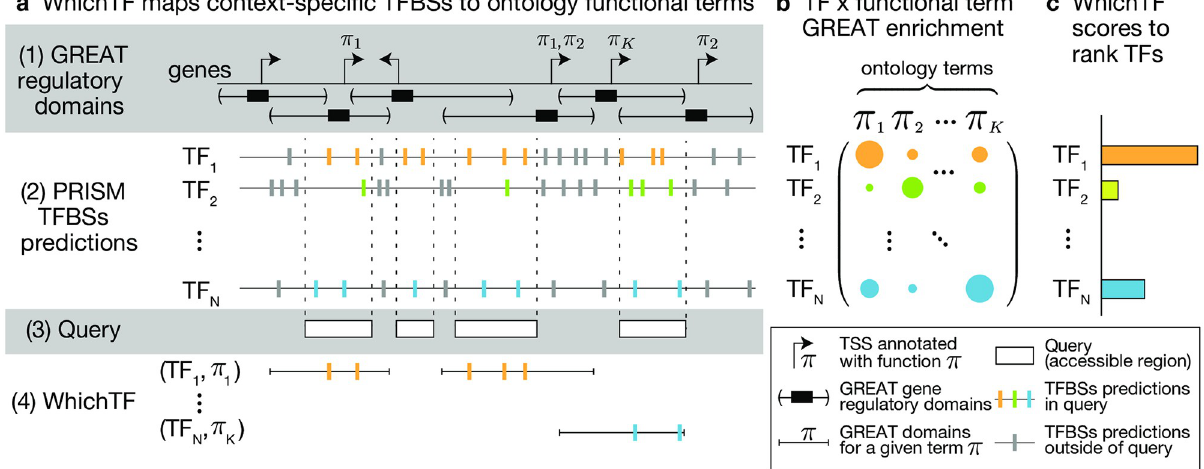
Fig 1. The WhichTF computational model. (a) WhichTF uses gene regulatory domain models and functional information in ontologies from the genomic region enrichment analysis tool (GREAT) (step 1) and conservation-based PRISM predictions of transcription factor binding sites (TFBS) (step 2). Given a user-defined set of putative gene regulatory genomic regions (step 3), WhichTF considers the top- K GREAT functional terms ( π 1 , ... , π K ) enriched in the query regions. For all pairwise combinations of a top- K term and a TF, WhichTF counts the number of TFBSs within the specified query regions (step 4). (b) The binomial and hypergeometric TFBS enrichment p -values for each ontology term are compiled in a TF-by-term summary statistic matrix (Methods). (c) Aggregating the summary statistics over terms, WhichTF returns a ranked list of TFs, ordered by predicted functional importance in the user-specific chromatin environment, with the corresponding scores and statistics. WhichTF also reports a set of ontology terms driving each enrichment (Methods). Here, TSS stands for transcription start